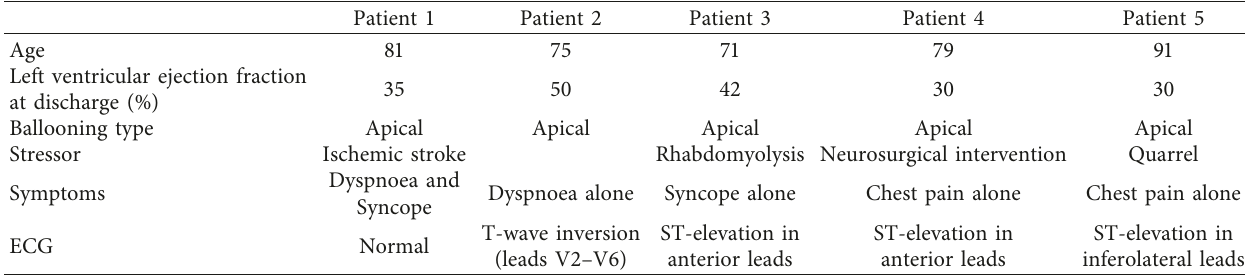
Table 4: Clinical characteristics of TTS and STEMI groups.